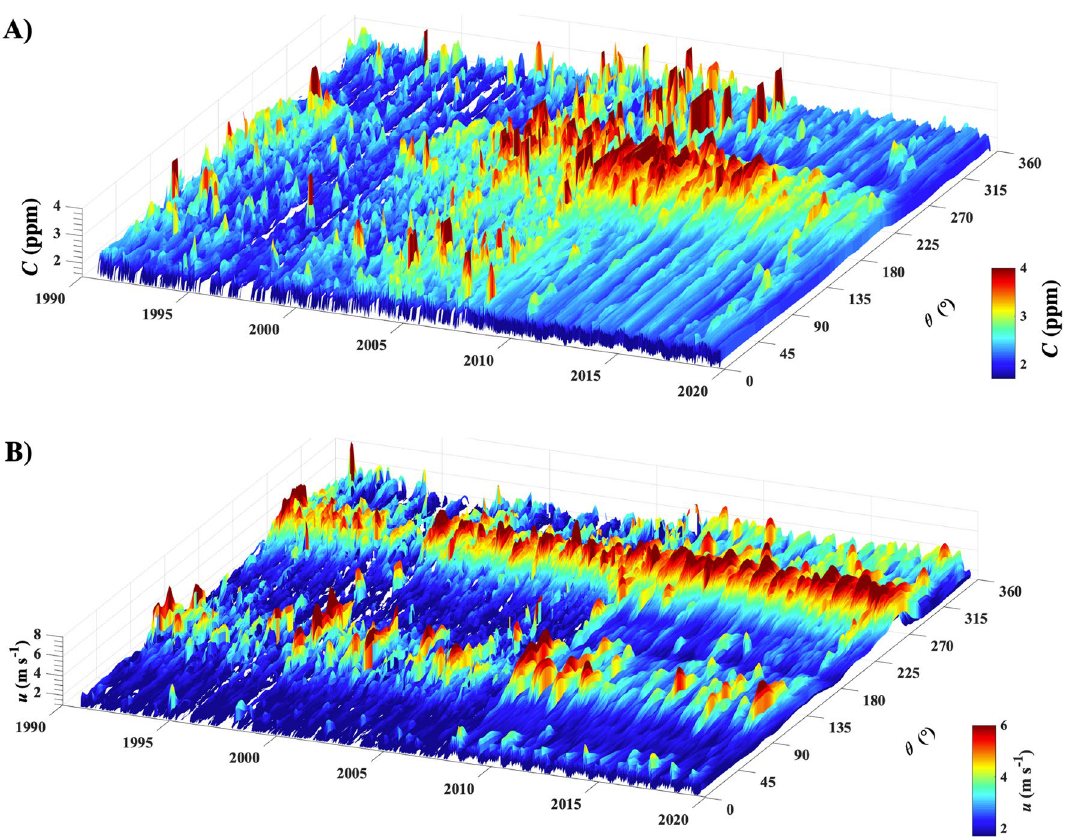
Figure 6. Time and direction, θ , resolved ( A ) average total hydrocarbon concentration, C ave (θ), and ( B ) wind speed, u . Data key for C and u on figure. C limit is clipped at 4